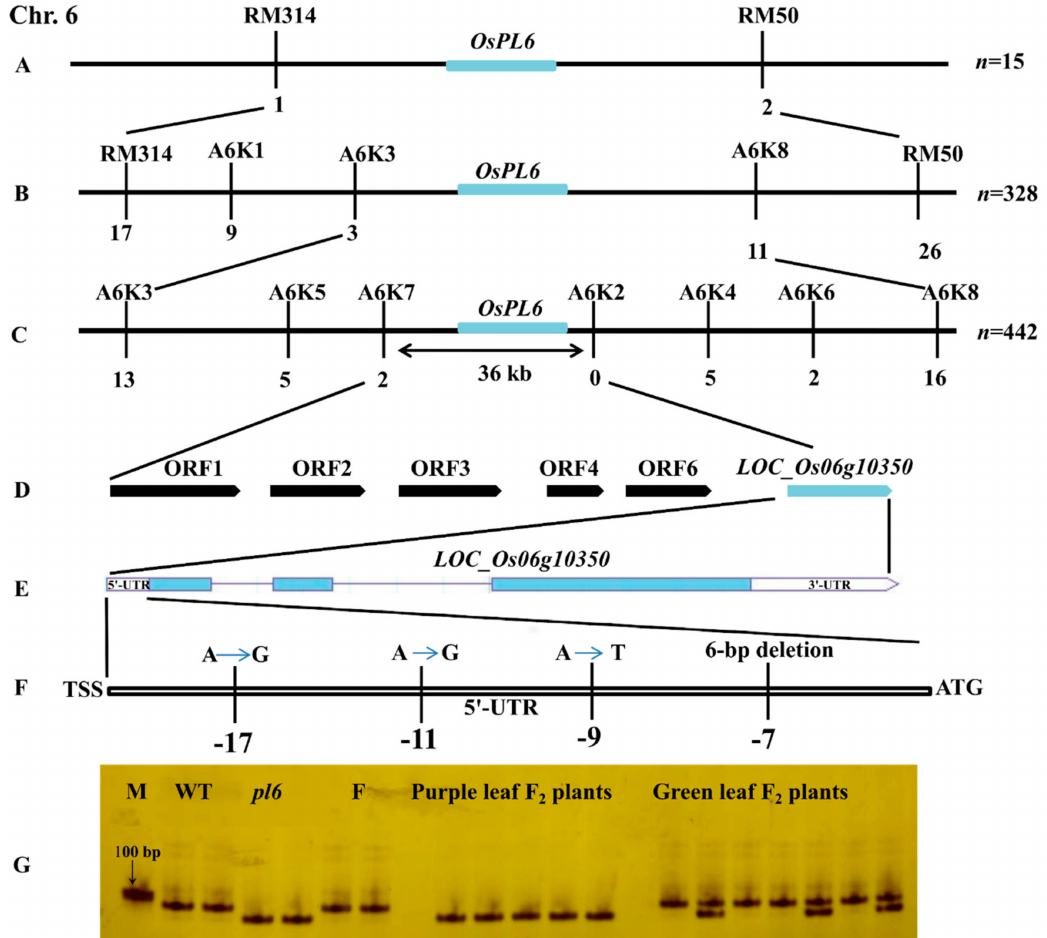
Figure 2. Map-based cloning of the OsPL6 gene. ( A ) The OsPL6 gene was located between markers RM314 and RM50 on chromosome 6 by Bulked segregate analysis (BSA); ( B ) Primary map of OsPL6 graphed to a section between the InDel markers of A6K3 and A6K8 by using 328 F 2 individuals of pl6 ; ( C ) Fine mapping of OsPL6 to a gap of 36 kb between the markers A6K7 and A6K2 through 442 F 2 individuals of pl6 ; ( D ) Six putative genes were predicted in the 36 kb section, and LOC_OsO6g10350 was hypothetical to be OsPL6 ; ( E ) The structure of the OsPL6 gene where the boxes implied exons and lines pointed as the introns; ( F ) Three substitution and one 6-bp deletion were found on 5 (cid:48) -UTR region of the gene; ( G ) The detection of sequence polymorphism with indel marker. M, marker (DL2000 marker, Takara Biomedical Technology, Beijing, China); pl6 , mutant; F, father (Zhenong 104); WT, wild type (Zhenong